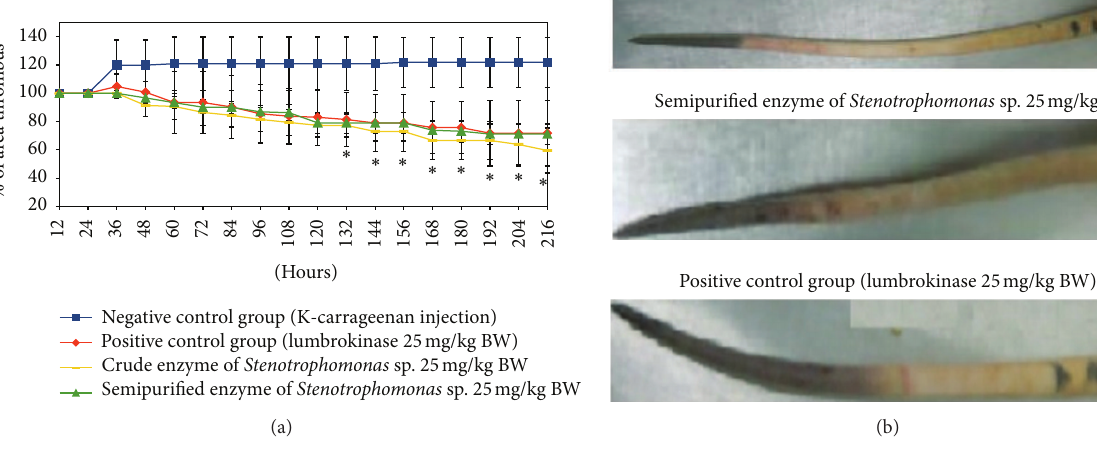
Figure 3: Thrombus degradation in rats tail following oral enzyme treatment. Percentage of thrombus left (a). Thrombus area on day fifth (b). ∗ significance difference compared with negative control group ( 𝑝 < 0.05